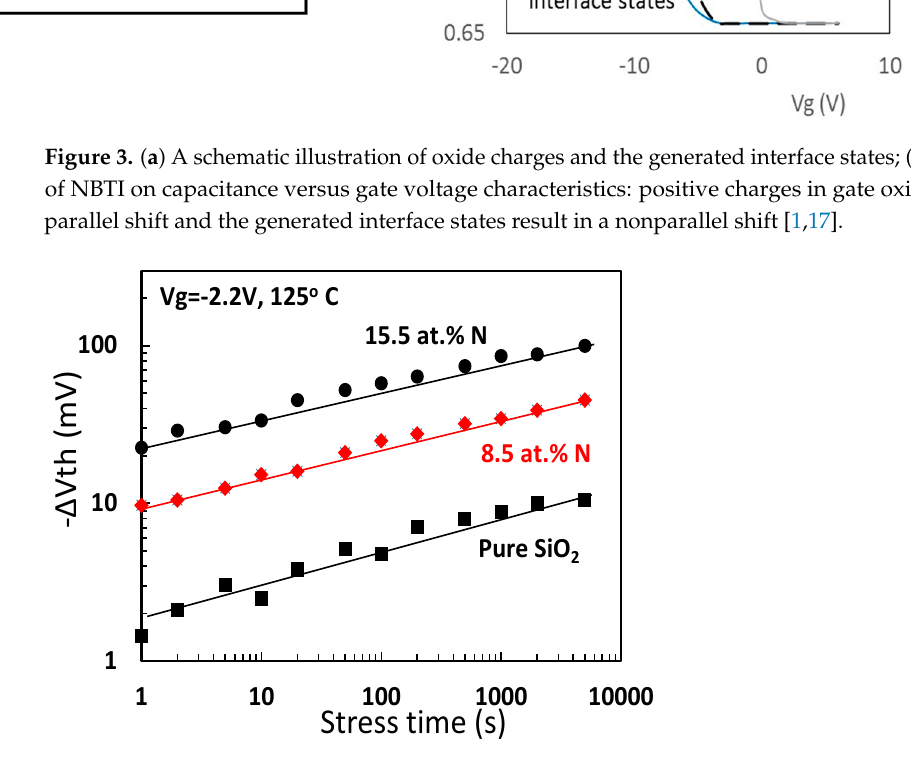
Figure 4. Increase of nitrogen density in SiON raises NBTI. The NBTI follows a power law [14]. On the physical process, the Si–H bond at the interface is generally believed to be the precursor for generated interface states [17]. During NBTI stress, Si–H is ruptured, and